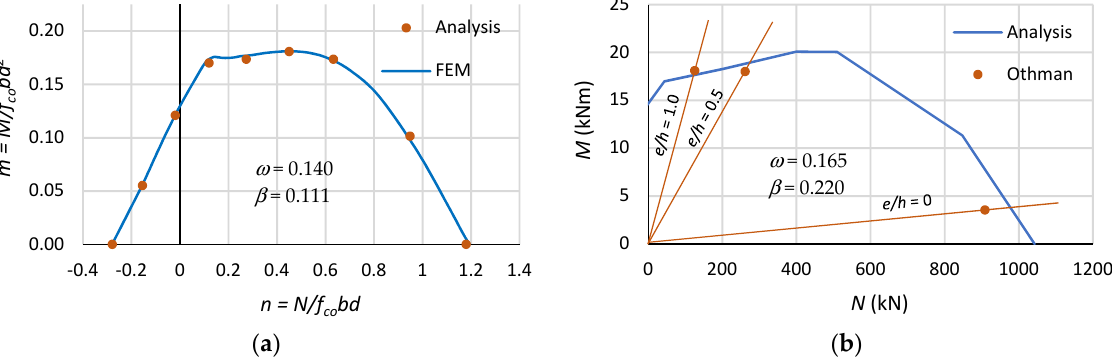
Figure 6. Comparisons: ( a ) analysis vs. FEM and ( b ) analysis vs. experimental results (data from [21]).